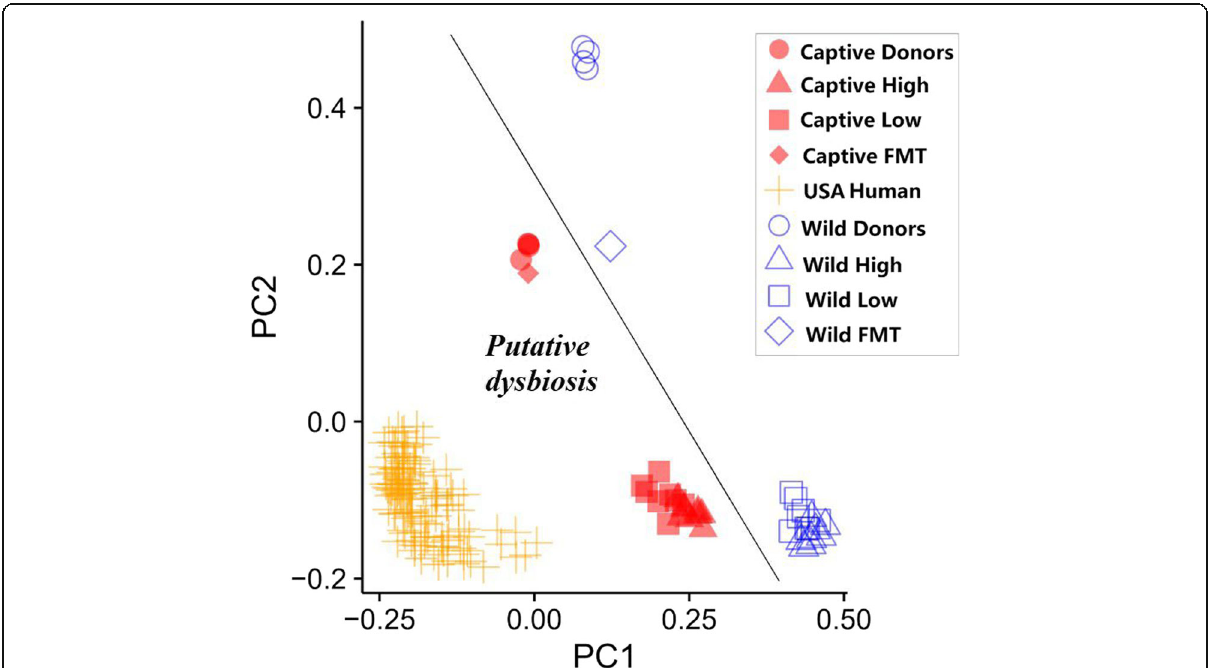
Fig. 3 Unweighted UNIFRAC beta diversity per treatment group, individual NHP donors, NHP donor pool used for the FMT, and USA humans. FMT here indicates the pooled fecal samples used to make the single-dose FMT gavage, whereas donors indicate the individual fecal samples used to create the pooled dose. Fecal pellet samples cluster by treatment group. Adonis permutation test showed statistically significant clustering by treatment group ( R 2 = 0.24673, p < 0.001) with the majority of the difference explained by the FMT administered ( R 2 = 0.18365 ) rather than diet ( R 2 = 0.03597 ). USA human indicates unweighted UNIFRAC beta diversity of fecal samples from USA individuals from the Global Gut study and fecal samples from this study. The captive groups cluster closer with USA individuals than wild groups (Adonis test R 2 = 0.15861, p < 0.001 ). A straight line was added to highlight the difference in clustering between wild and captive